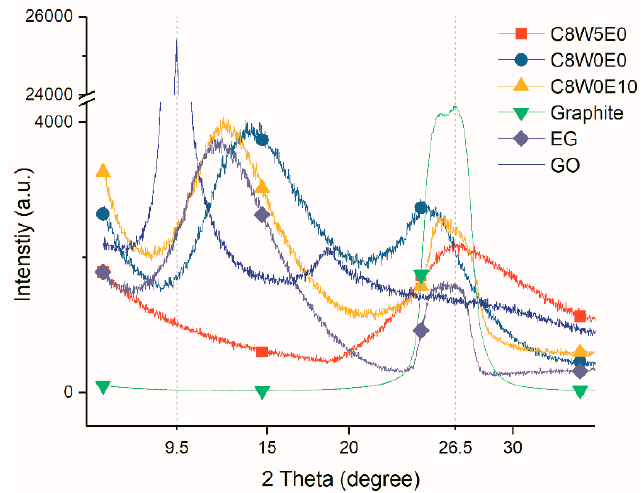
Figure 10. XRD curves of different samples.